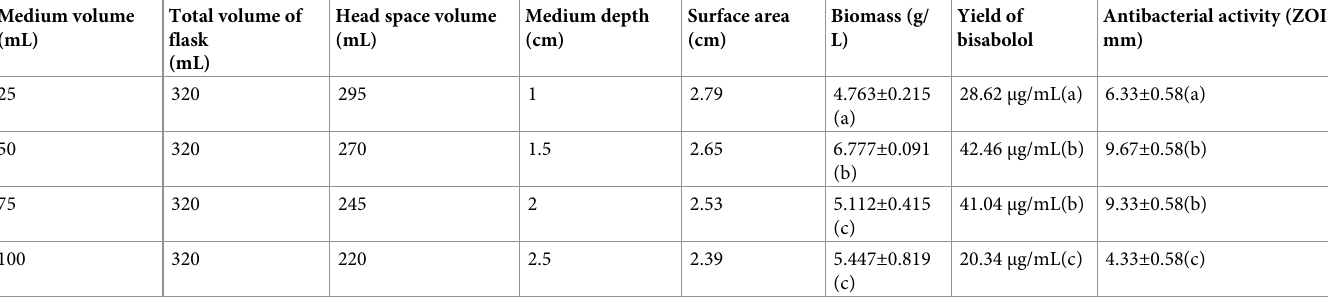
One-way ANOVA (Tukey’s Multiple Comparison test) was performed to check the potential statistical differences between the data (column wise) of biomass (g/L), yield of bisabolol and antibacterial activity (ZOI- mm) in different medium volume (mL). There were valid statistical differences in most of the cases (P < 0.05),the three different letters a, b, c indicates significant difference and same letter at two positions indicate no statistical